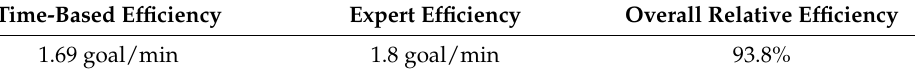
Table 2. Overall efficiency results.